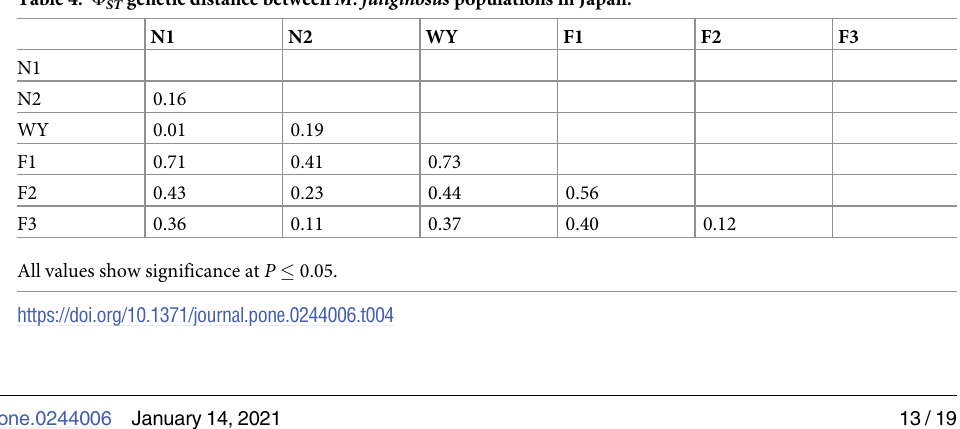
Table 4. F genetic distance between M . fuliginosus populations in Japan. ST